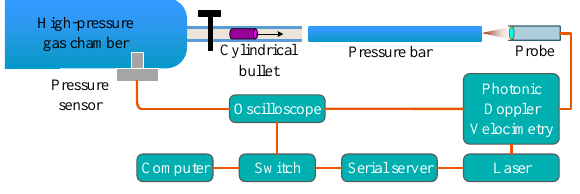
Figure 6. The diagram of testing system.